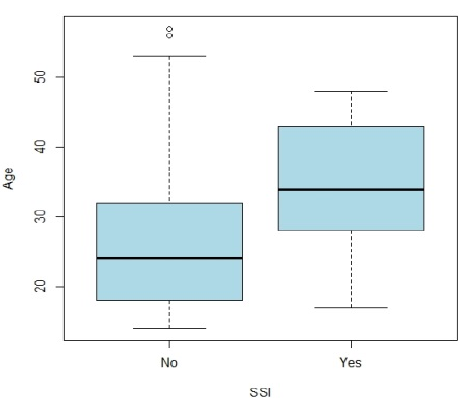
Figure 2. Association between age at surgery and SSI.